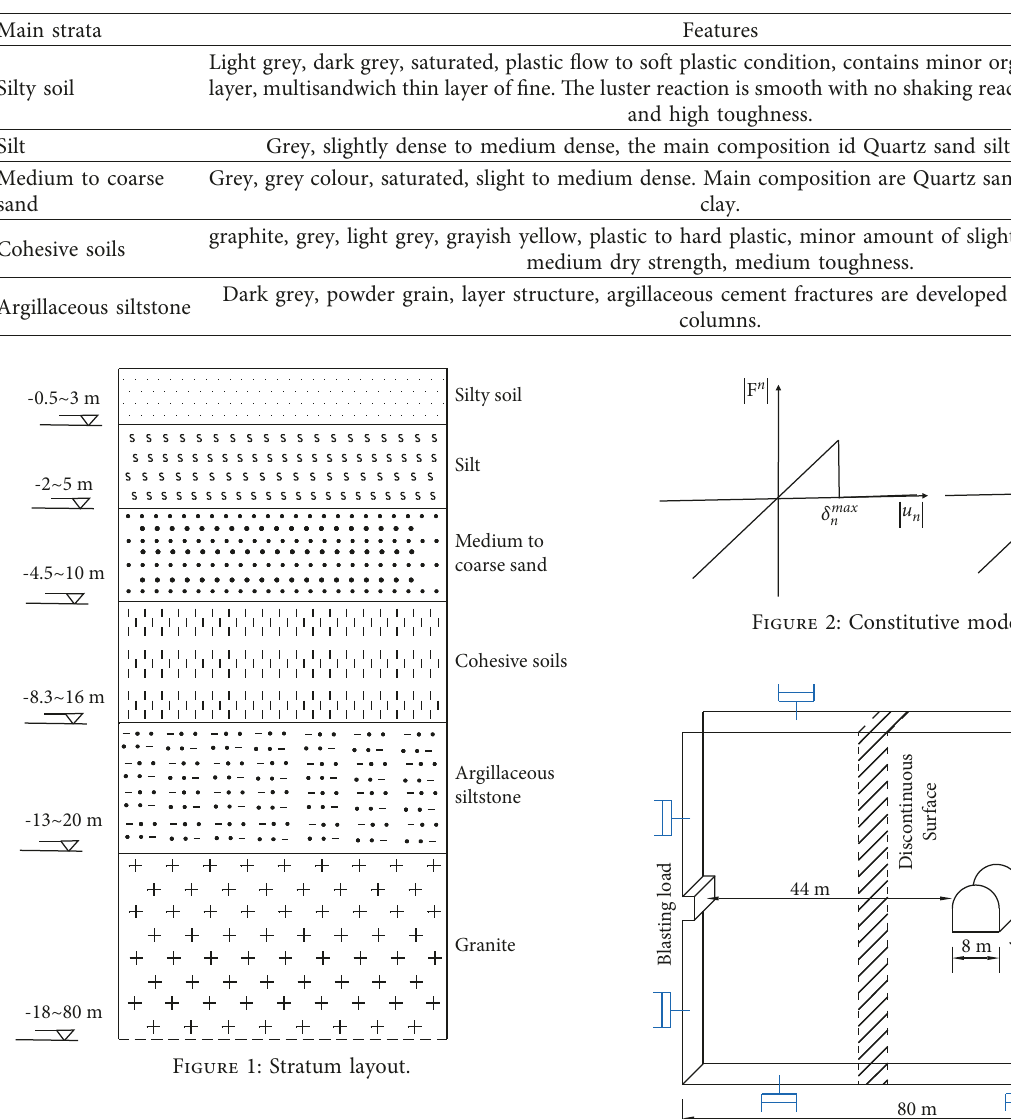
Figure 1: Stratum layout.